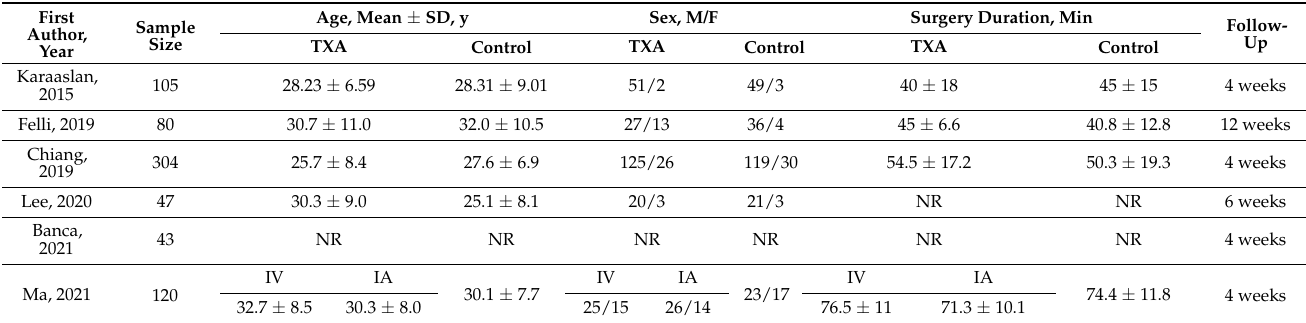
Table 1. Baseline characteristics and demographics of all included studies.